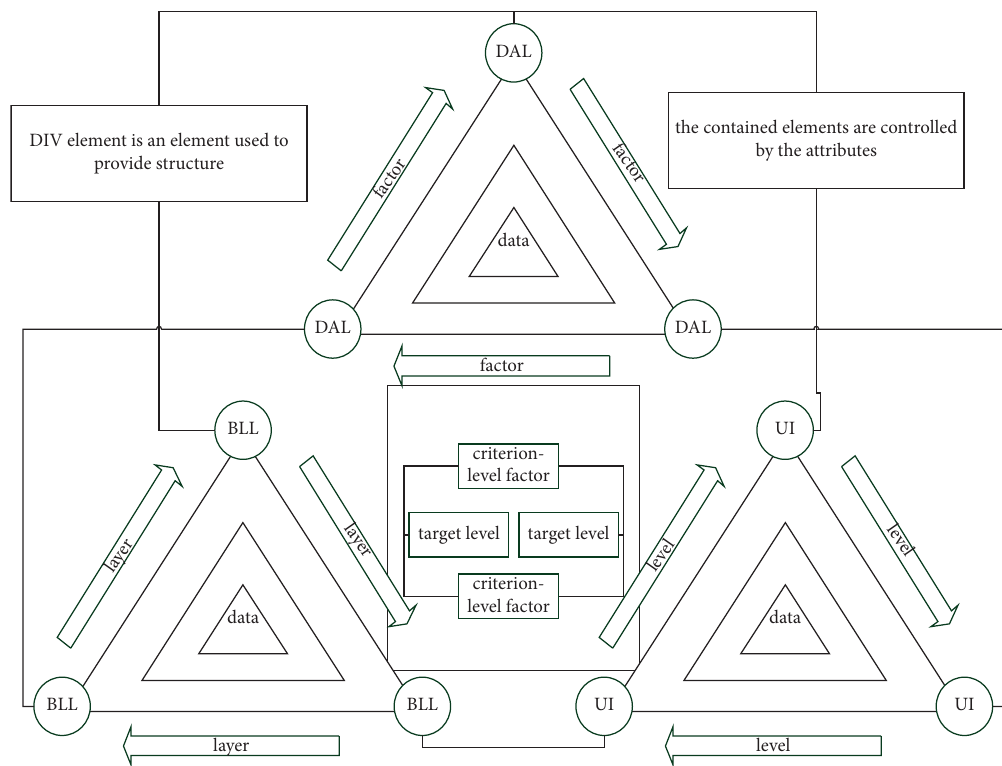
Figure 1: Big data management hierarchy